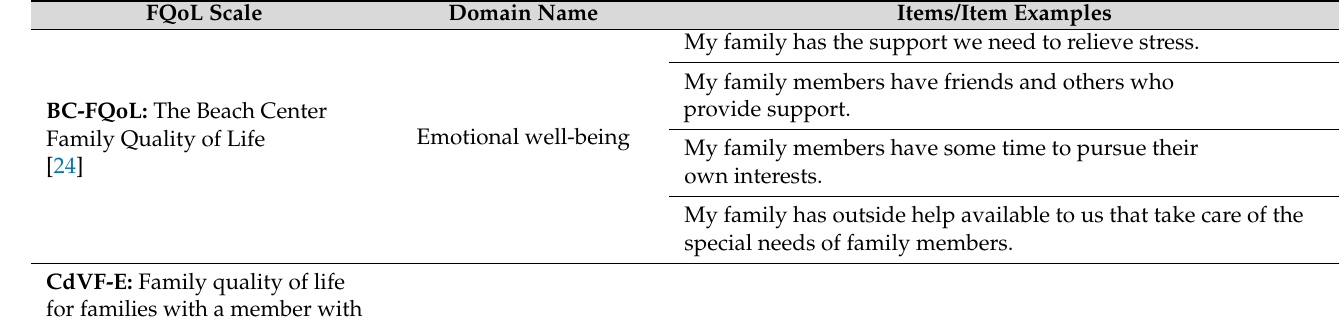
Table 5. Items/item examples considered in the domain of emotional well-being within each FQoL